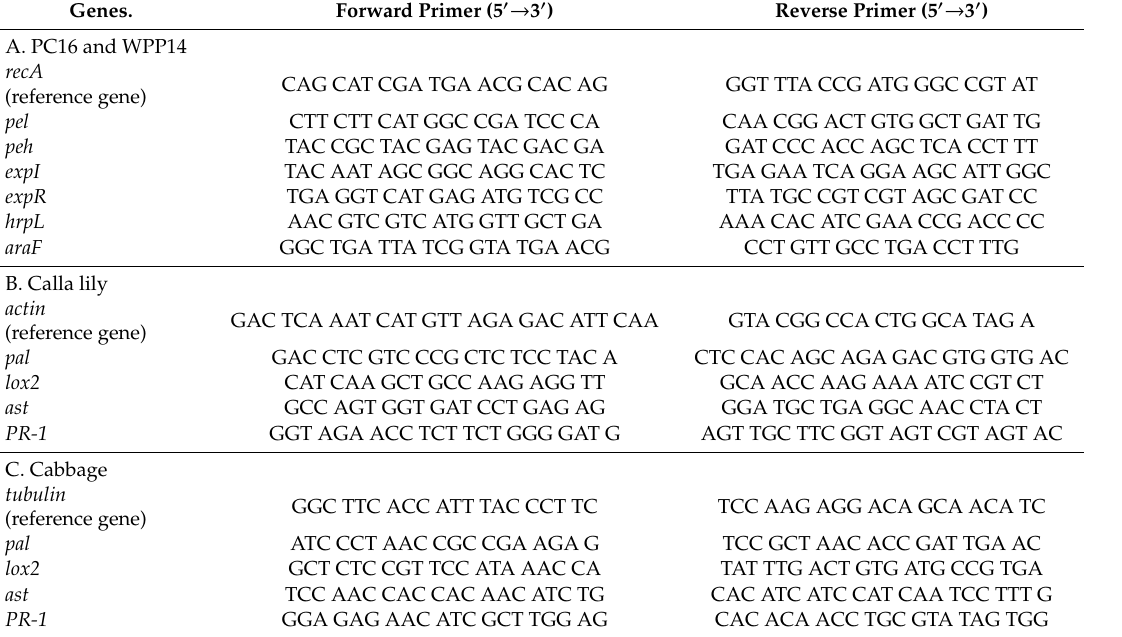
Table 1. Primers used for